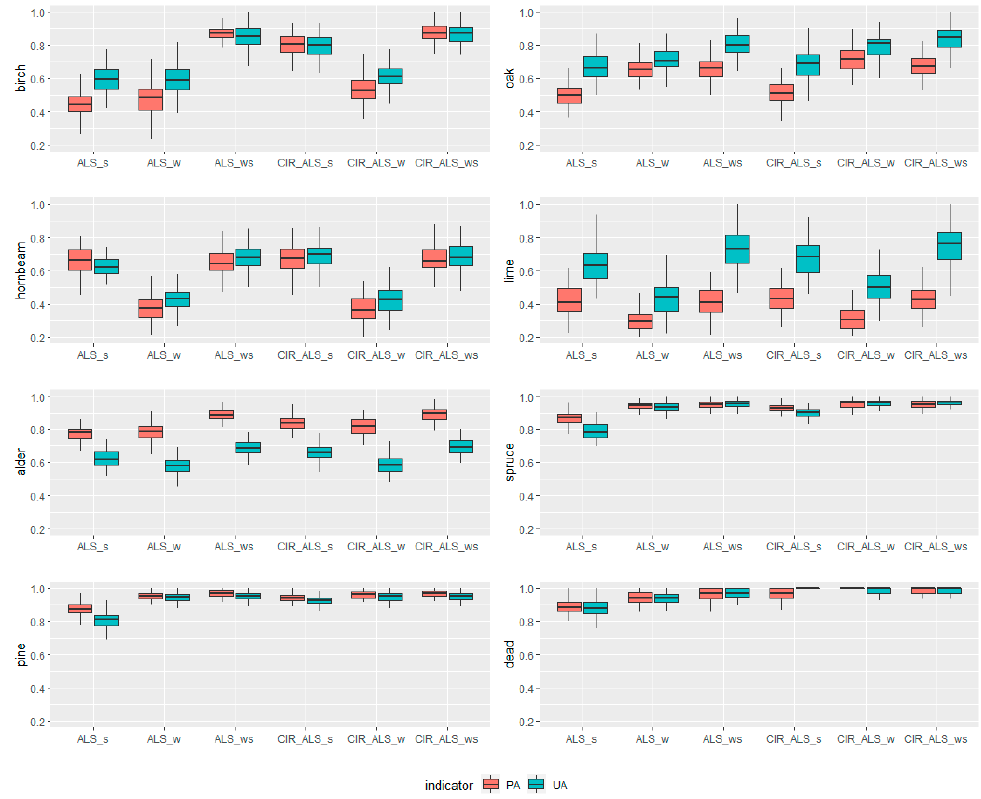
Figure 5. Box-and-whisker plot of the producer’s (PA) and user’s (UA) accuracies of specific tree species for the classification based on both point clouds and image information. The first and third quartiles define the box, the median is shown as “—”, and the whisker defines the range of the data without outliers. The ALS is the point cloud from the leaf-on (S) or/and leaf-off (W) season, whereas the CIR is the spectral information derived from the colour-infrared images.